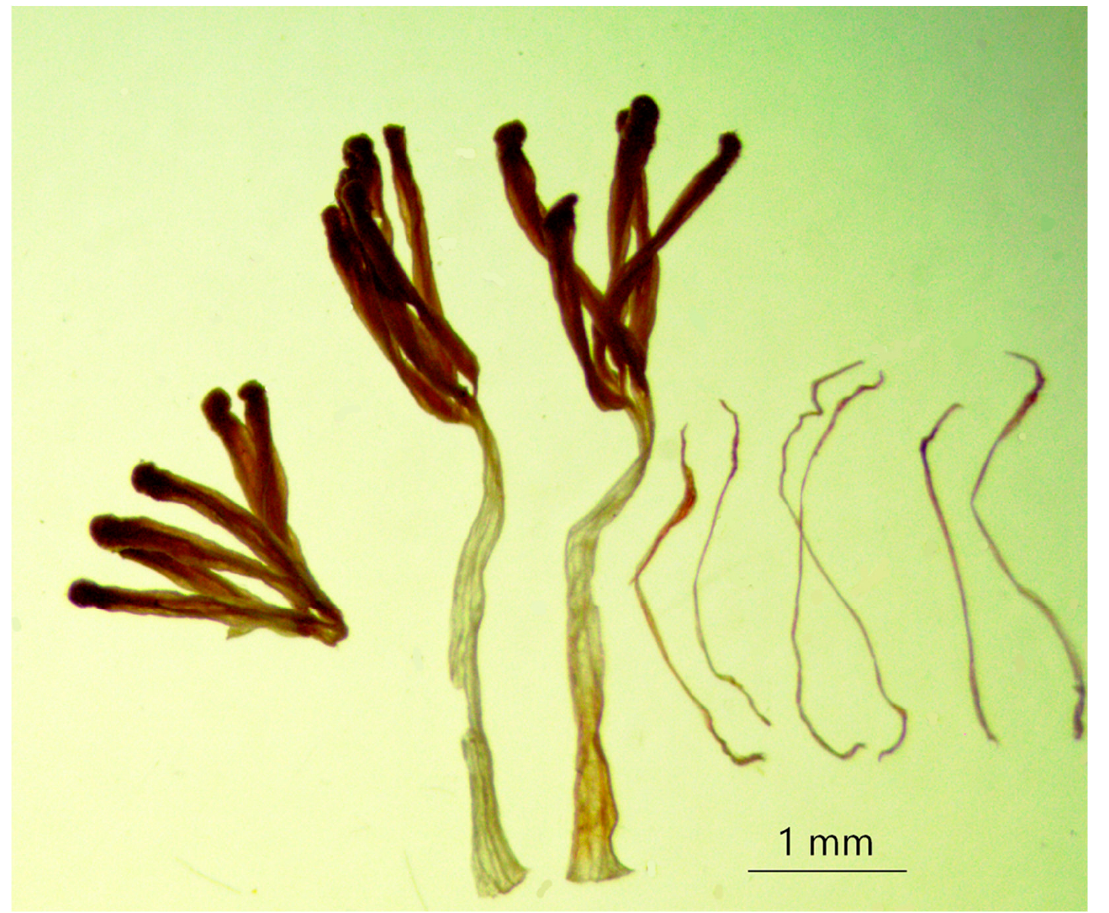
Figure 6. Typha lepechinii sp. nov.: Male flower (on the left) and the hairs of the axis (on the right). Photo: O. A. Kapitonova.